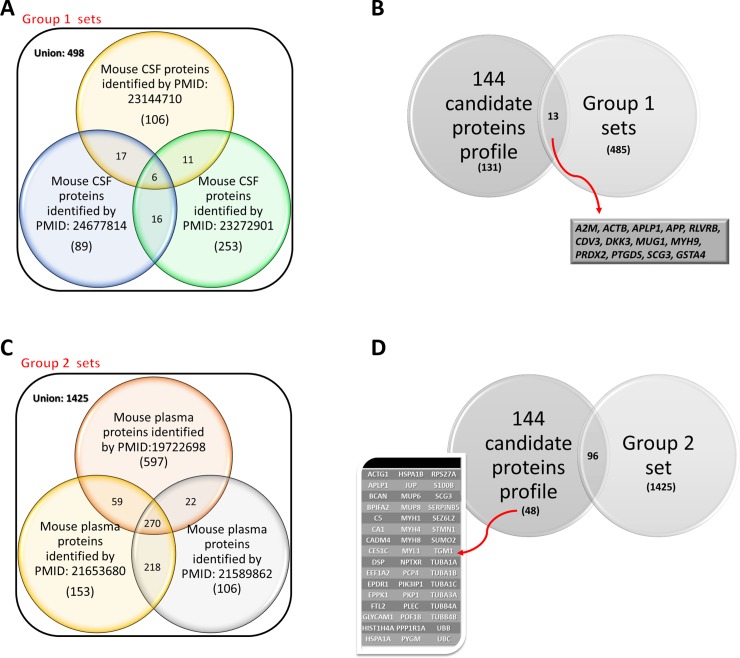
Venn diagram with CSF of CI/R-induced stroke compartmentalization.(A-B) Comparison of unique proteins identified in murine CSF with previously reported unique proteins in the CSF [20–22]. (C-D) Comparison of unique proteins identified in murine CSF with previously reported unique proteins in the plasma [23–25].